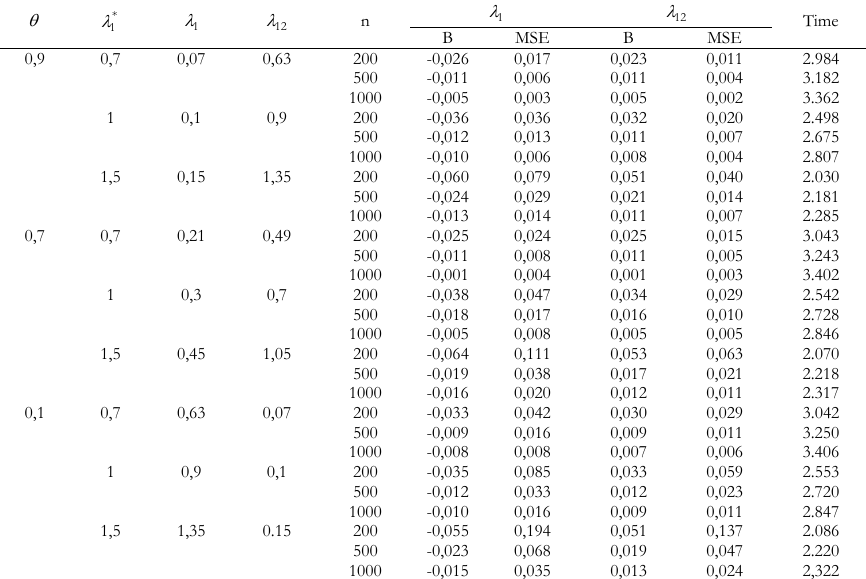
Estimates of the Weibull reliability parameters: complete